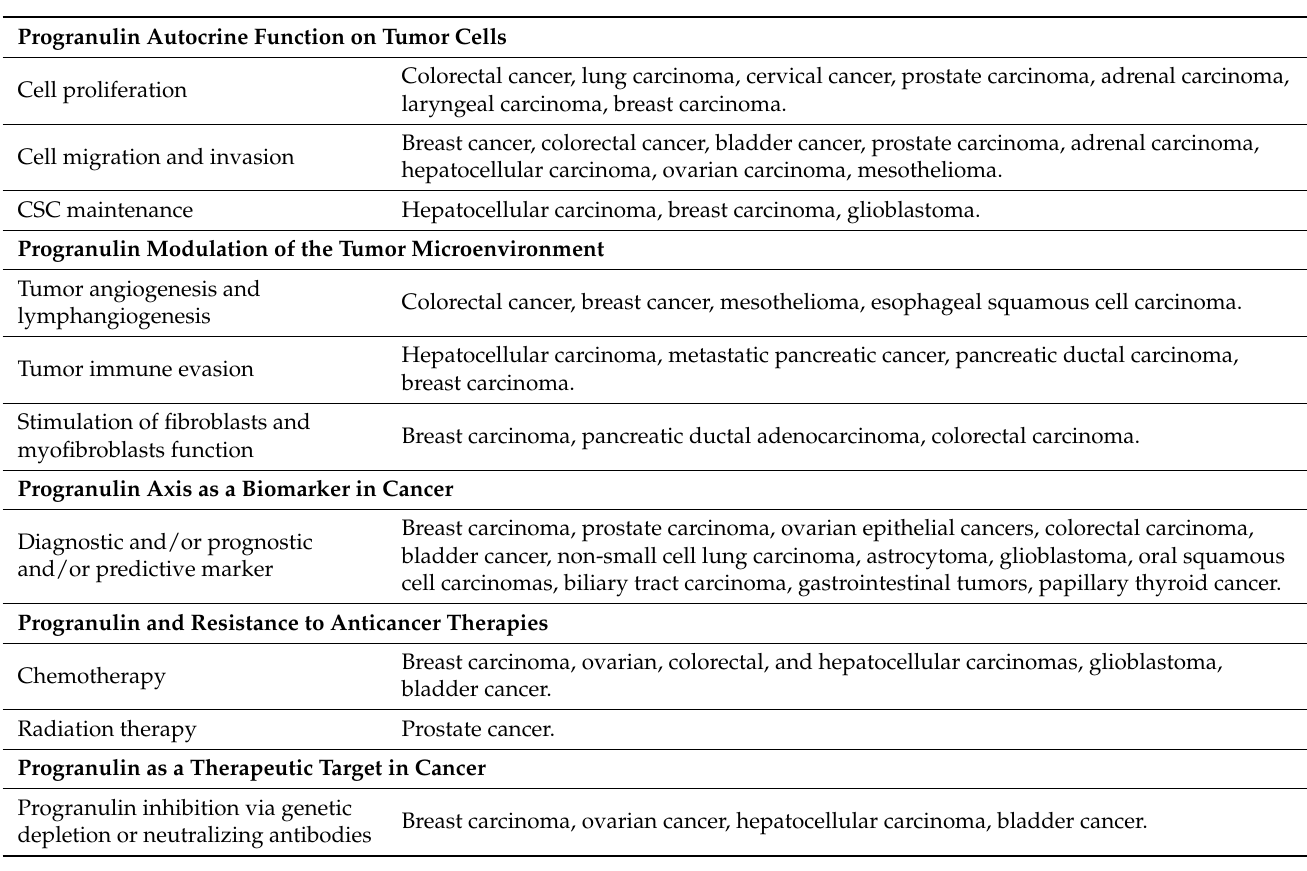
Table 1. Progranulin action in cancer. For references, see [15,74] and references throughout the